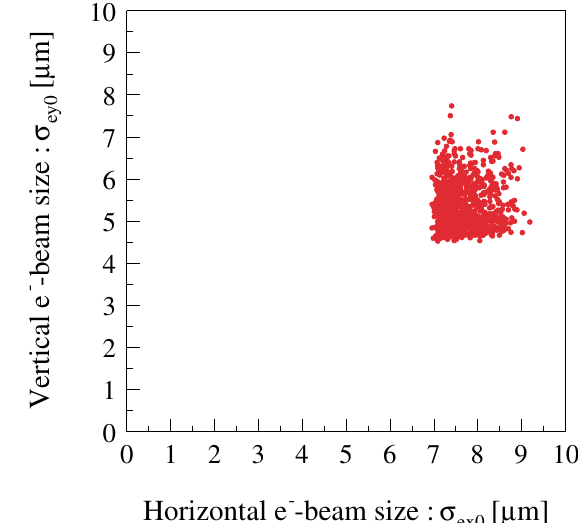
FIG. 10. (Color) Two dimensional plot of vertical and horizon- tal beam sizes simulated by SAD taking into account the precision of determining the optimum current of QY , QX , and QD .